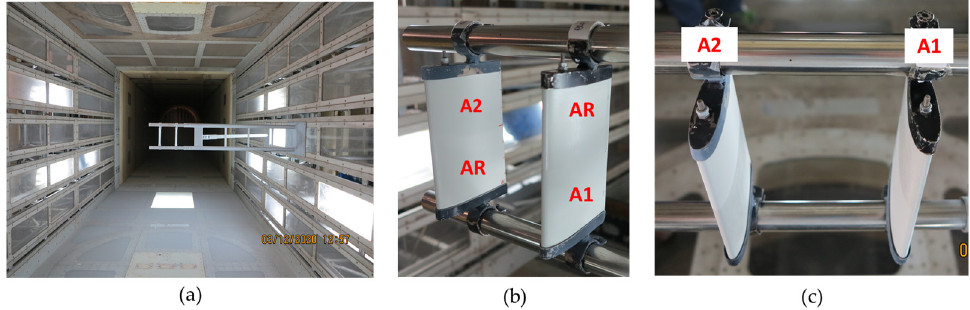
Figure 1. Different views of samples A mounted in the IWT facility; ( a ) front view, ( b ) lateral view, and ( c ) top view.